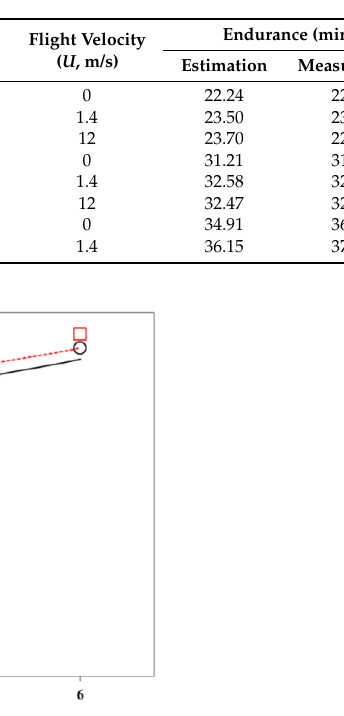
Table 3. Tested condition and comparison of estimated/measured endurance.